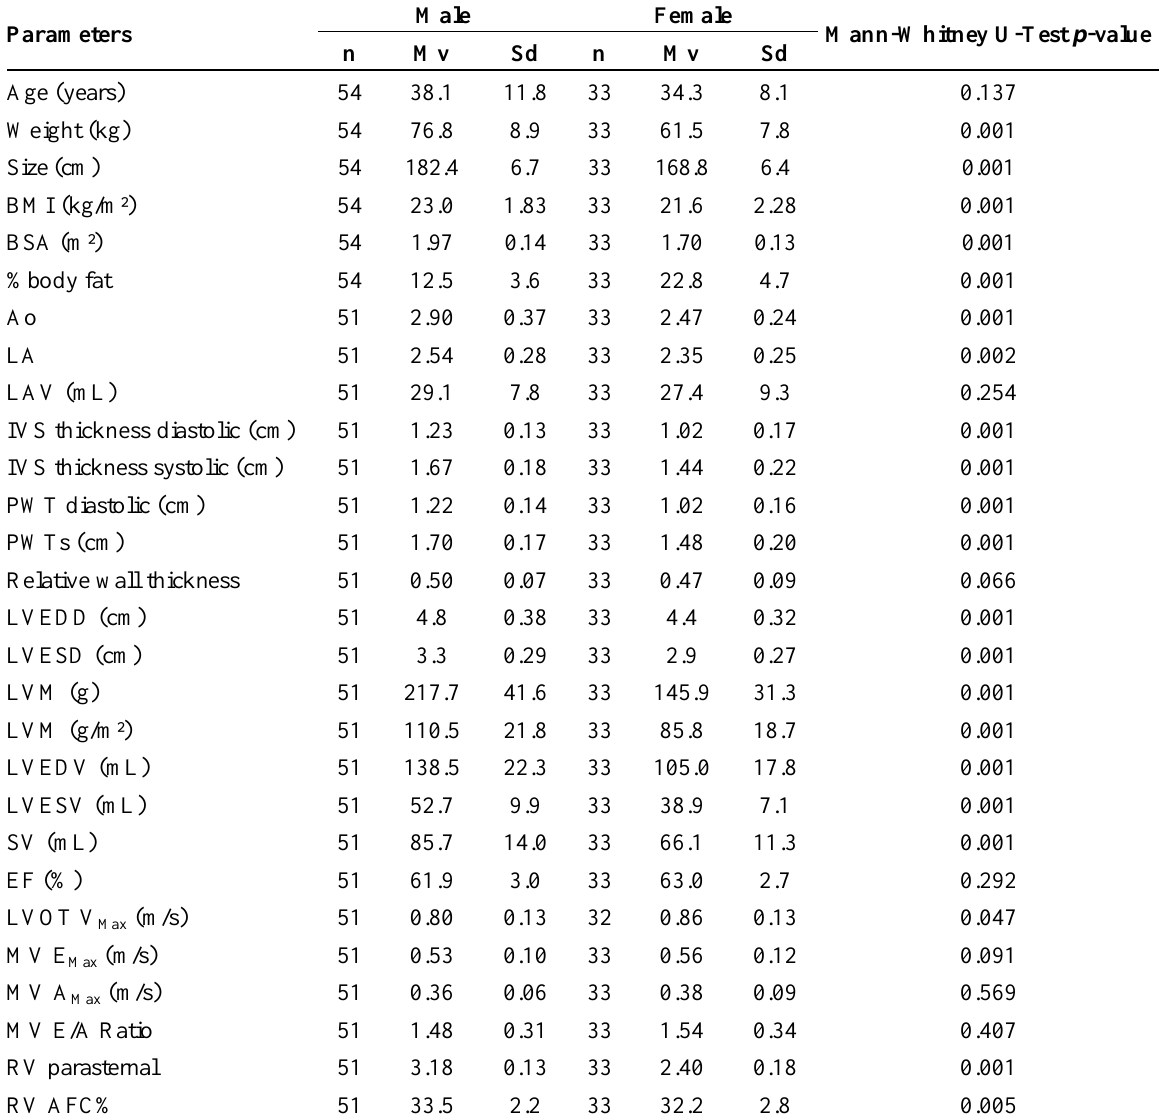
Table 1. Anthropometric and structural echocardiographic characteristics of the study population.